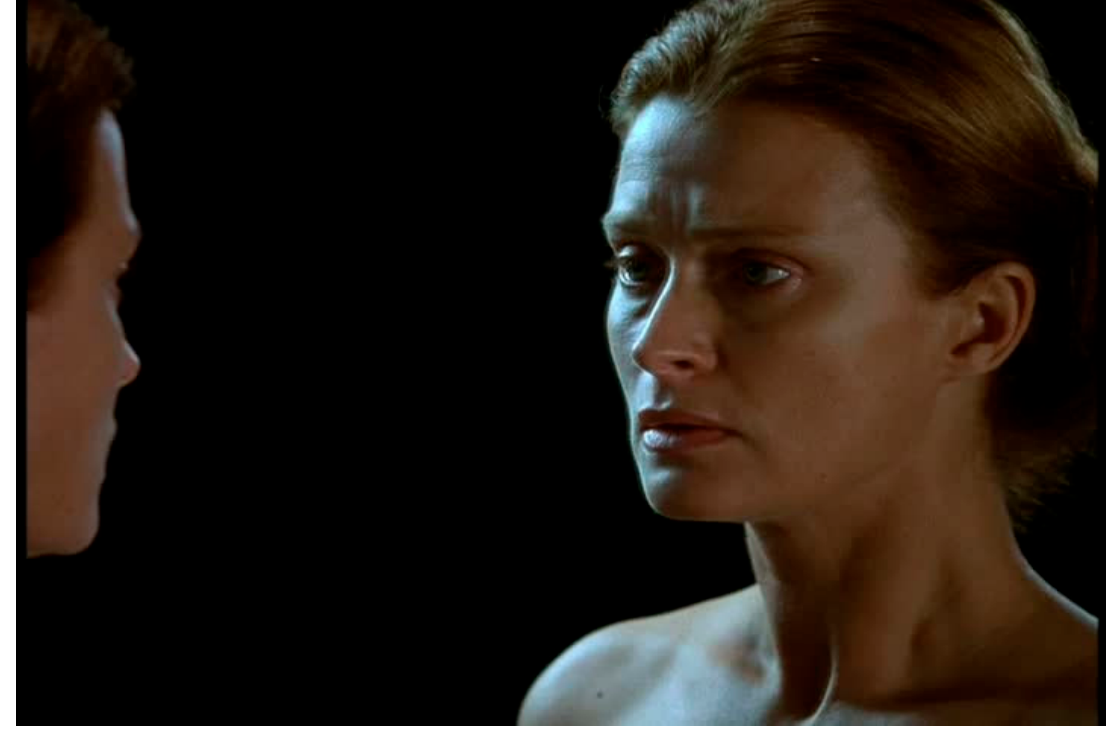
Figure 2. Marianne battles with herself, Isabelle in the midst.